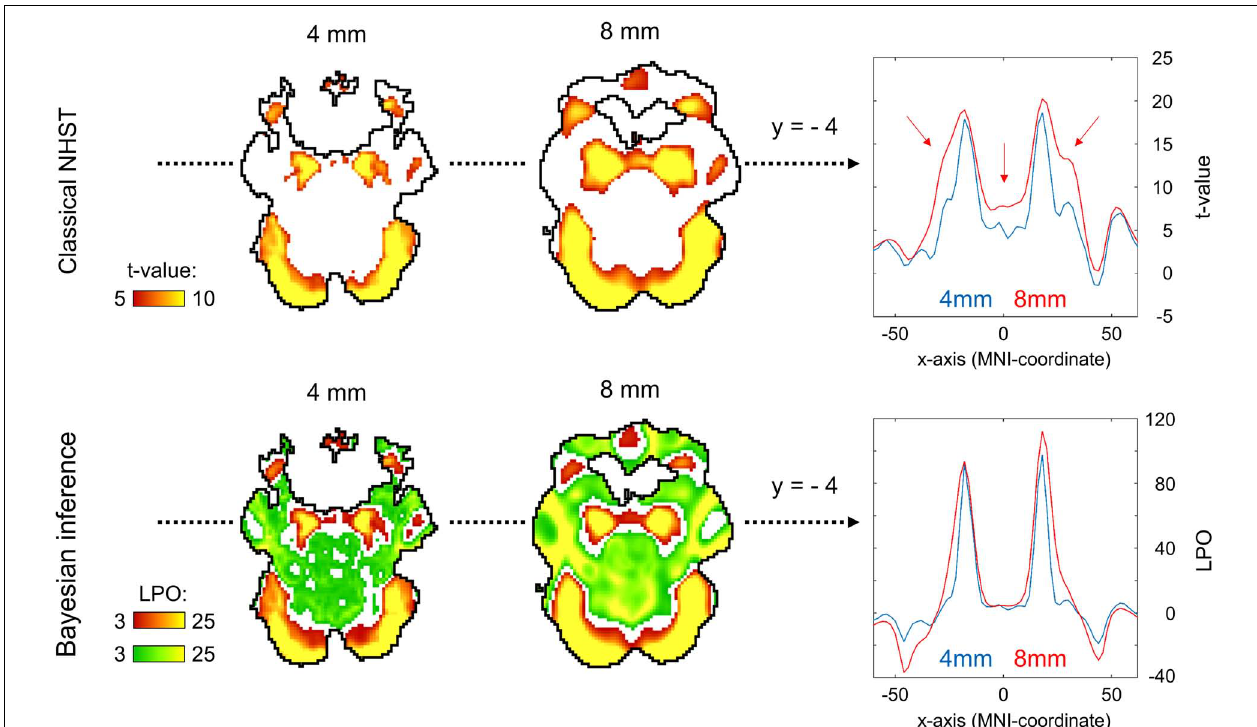
FIGURE 11 | Influence of spatial smoothing on classical NHST and BPI: results for the emotion processing task (‘Emotion > Shape’ contrast). Classical NHST was implemented using voxel-wise FWE correction ( α = 0.05). BPI was implemented using the ‘ROPE-only’ decision rule, P thr = 95% ( LPO > 3) and γ = 1 prior SD θ = 0.135%. Axial slice z = –14 mm (MNI152 standard space). Slice images have different outlines due to spatial smoothing (higher spatial smoothing increases the size of implicit masks for single subjects and group of subjects). In the panels on the right, 1-D images are presented for t-values and LPOs along the x-axis for y = –4 mm. The red arrows indicate a noticeable broadening of two peaks of local maxima (left and right amygdala) at higher